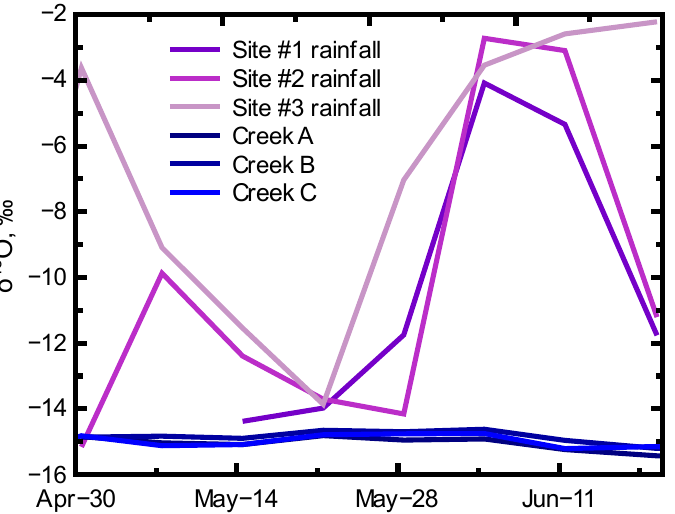
Figure 9. Temporal trends of δ 18 O values for spring rainfall collected at the three snowpack sampling locations (Sites #1 – 3) and the three (A, B, and C) ephemeral creeks located between sites #2 and #3.